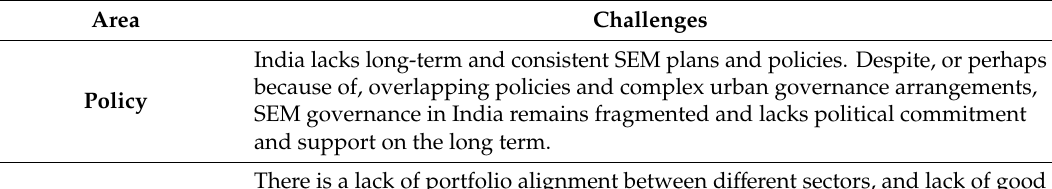
Table 1. PASTEL (Political, Administrative, Socio-environment, Technological, Economic, and Legal) analysis for SEM in